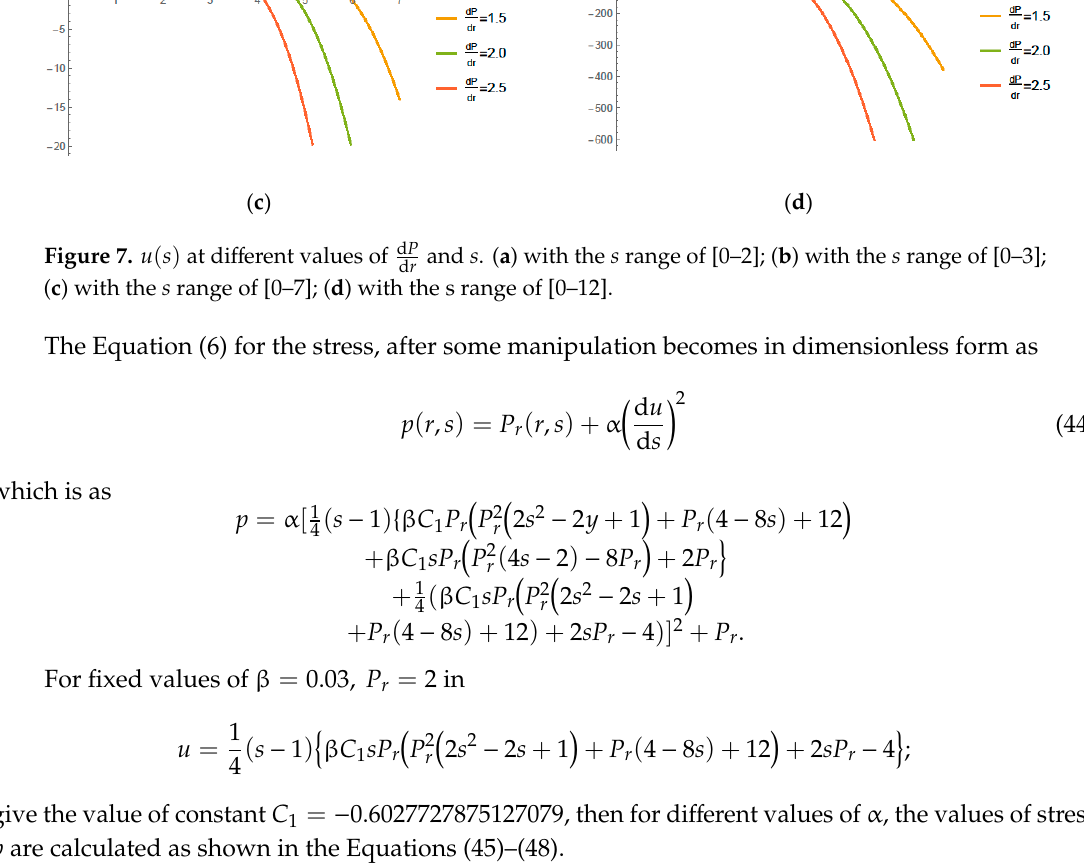
Figure 6. 𝑢(𝑠) at different values of (cid:2914)(cid:3017)